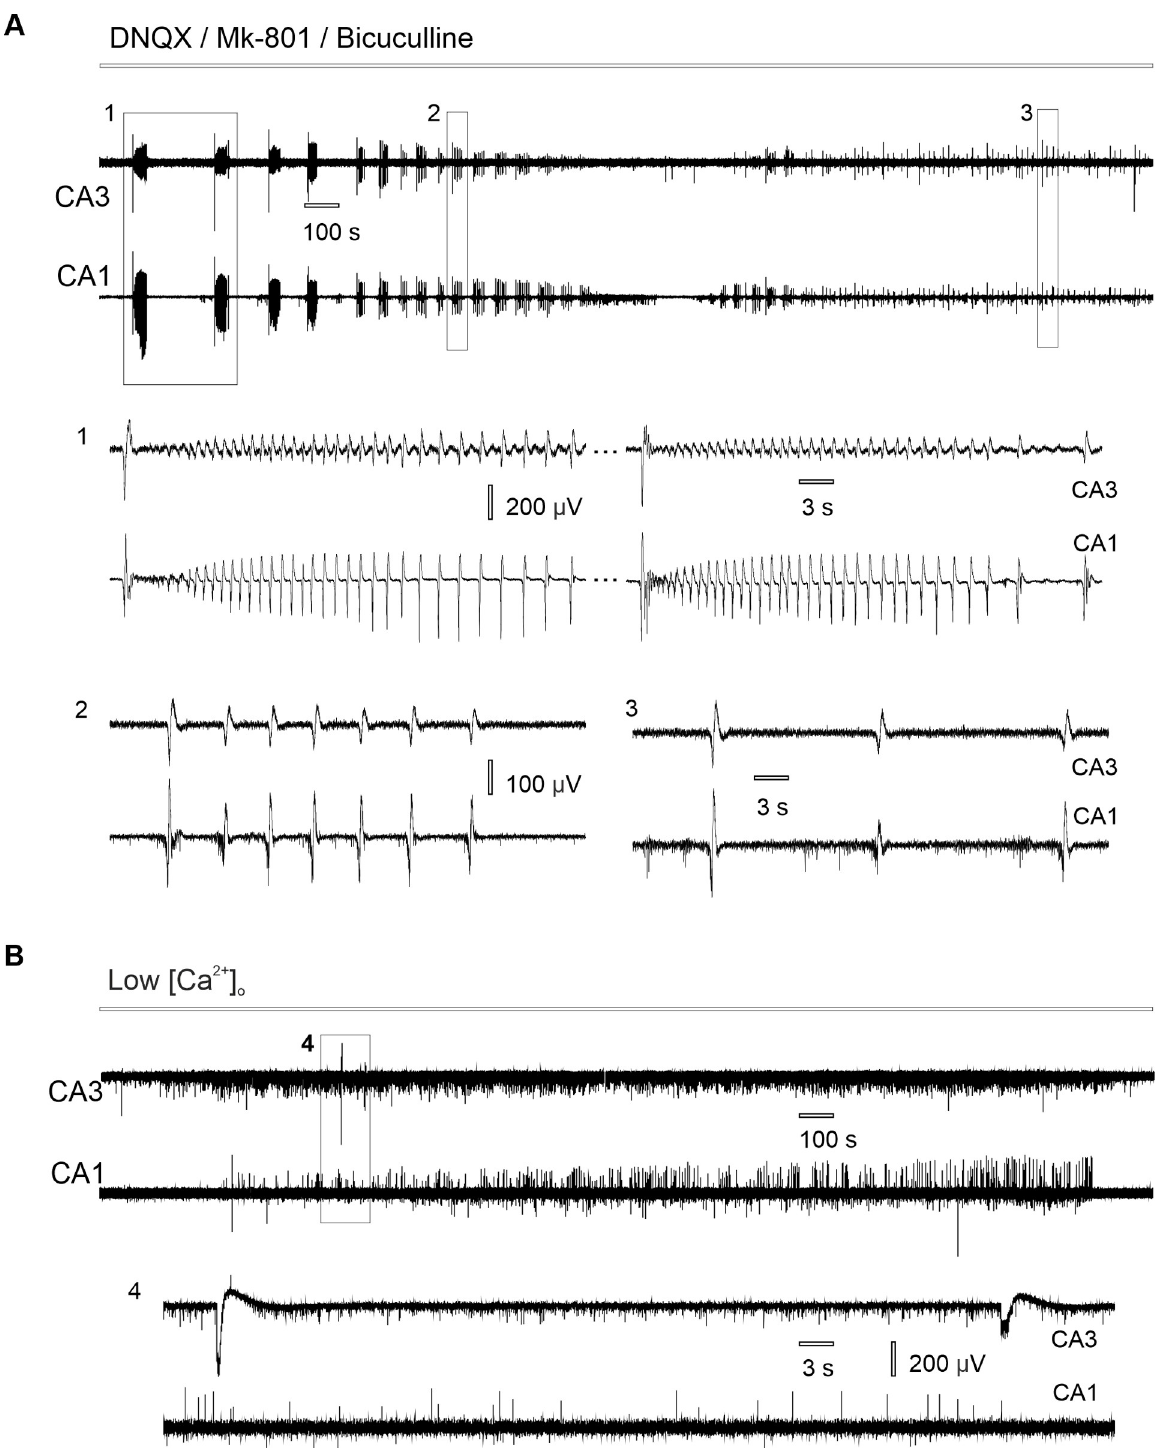
Fig 1. Spontaneous hippocampal epileptiform discharges in CA3 and CA1 under nonsynaptic conditions. (A) Simultaneous recording of synchronous epileptiform activity induced in synaptic blockers aCSF: (1) bursts of discharges, (2) single epileptiform discharges, (3) epileptiform discharges appear simultaneously in CA3 and CA1, while population spikes only in CA1. (B) Nonsynaptic population spikes appear in low-Ca 2+ aCSF: (4) epileptiform activity is not synchronized between CA3-CA1 hippocampal zones.